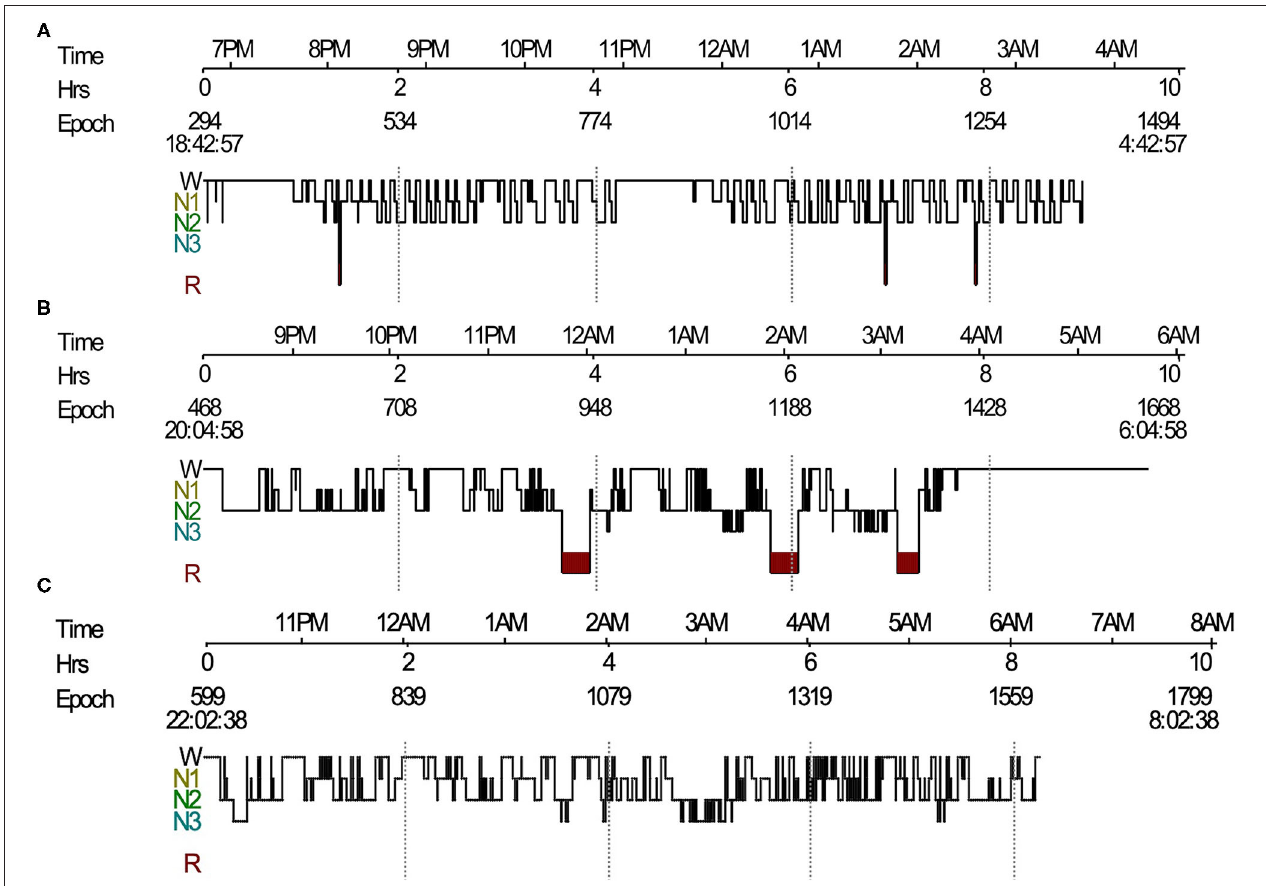
FIGURE 1 | Sleep histogram. (A) Sleep histogram in a patient with LGI1-antibody encephalitis revealed severe impaired sleep structure, short REM sleep episodes mixed with NREM sleep, and no N3 sleep. (B) Follow-up PSG showed identified sleep architecture and stable REM sleep. (C) Sleep histogram in a Morvan’s syndrome patient showed absence of REM sleep and frequent shifts between wake and NREM sleep. LGI1, leucine-rich glioma-inactivated protein 1; REM, rapid eye movement; NREM, non-rapid eye movement; PSG,